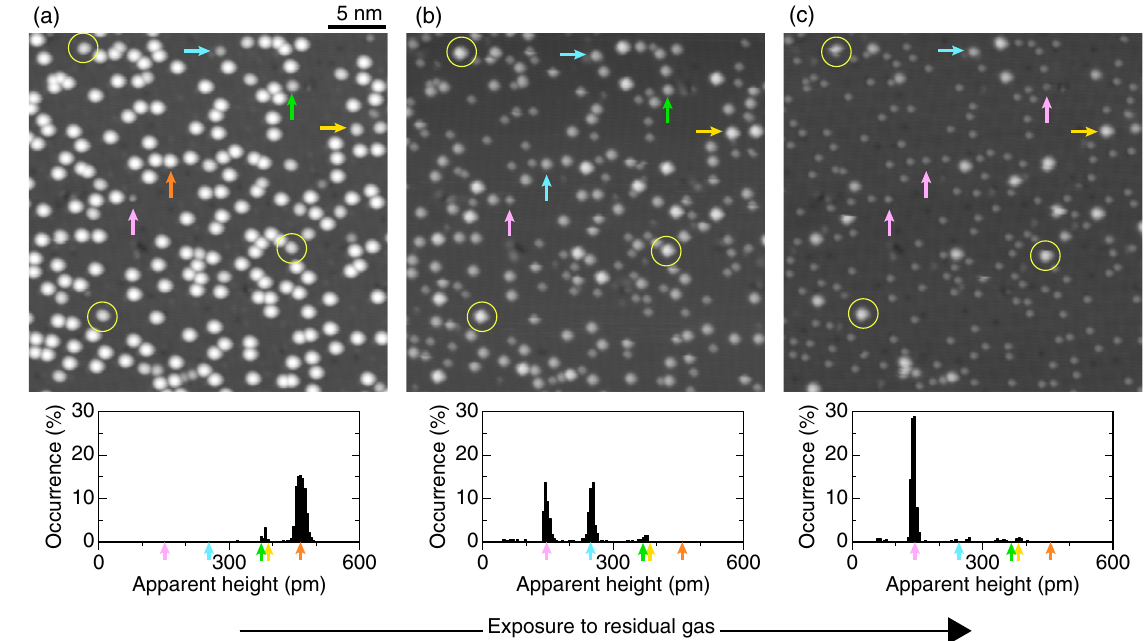
FIG. 6. Distinguishing clean and hydrogenated RE adatoms. Sequence of STM images of Dy on gr = Ir ð 111 Þ acquired before, during, and after exposure to gas, mainly H 2 , desorbing from the cryostat walls upon heating up the STM. (a) Reference STM image: The arrows indicate a clean Dy atom (orange), a Dy dimer (yellow), and contaminated atoms (green, cyan, and pink). Yellow circles highlight some Dy dimers that are used as landmarks ( T ¼ 6 . 5 K, p ¼ 1 × 10 − 10 mbar). (b) Same region during ( T ¼ 20 K, p ¼ 3 × 10 − 9 mbar) and (c) after ( T ¼ 33 K, p ¼ 3 × 10 − 10 mbar) massive exposure to H 2 desorbing from the cryogenic shields. The arrows indicate the same objects as in panel (a), with the colors adapted according to the new apparent heights. Parameters for all images: V ¼ 20 pA, Θ ¼ 0 . 5% ML, W tip. The bottom panels show histograms of the observed apparent heights for each measurement, with I t Dy statistics on approximately 450 protrusions